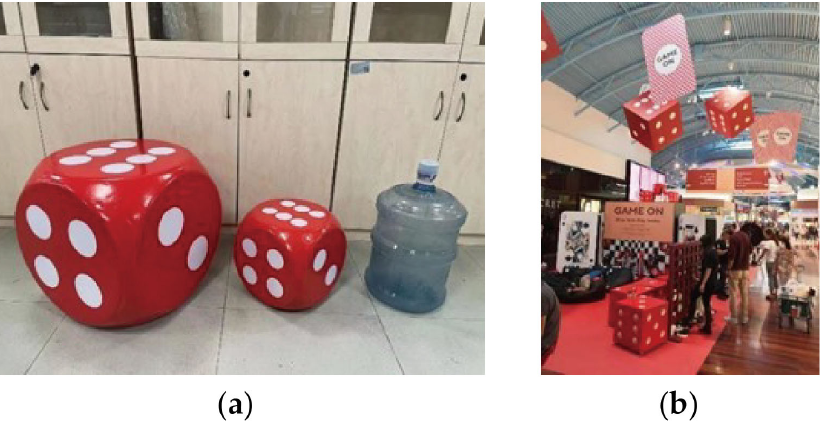
Figure 2. Die ‐ like furniture that can be used as the targets for the proposed registration method: ( a ) the round corner dice (photo taken at the Sun Yat ‐ sen University, Guangzhou, China); ( b ) the sharp ( a ) the round corner dice (photo taken at the Sun Yat-sen University, Guangzhou, China); ( b ) the corner dice (photo taken at the Crosslron Mills shopping center, Calgary, Canada). sharp corner dice (photo taken at the Crosslron Mills shopping center, Calgary,